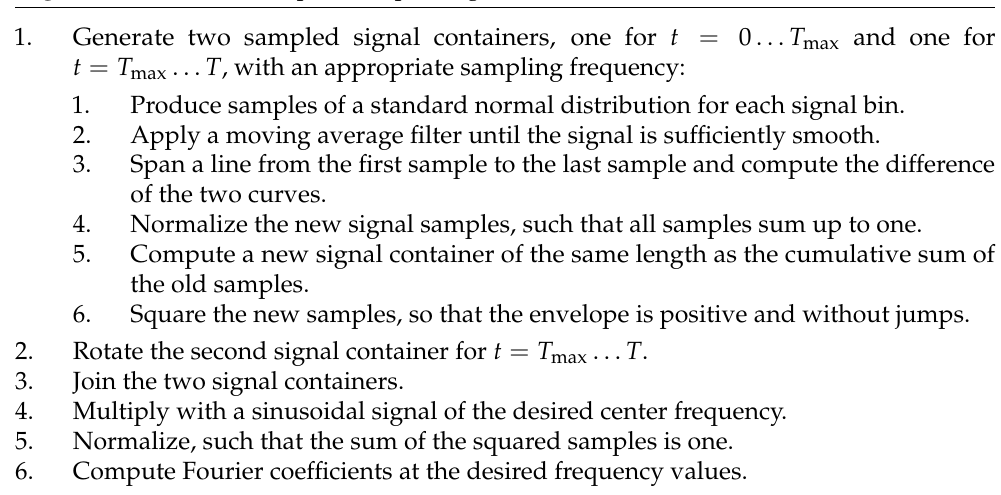
Algorithm 1 outlines roughly a scheme to generate random dynamic linear impulse response functions obeying the above defined rules. Algorithm 1. Random impulse response generator.